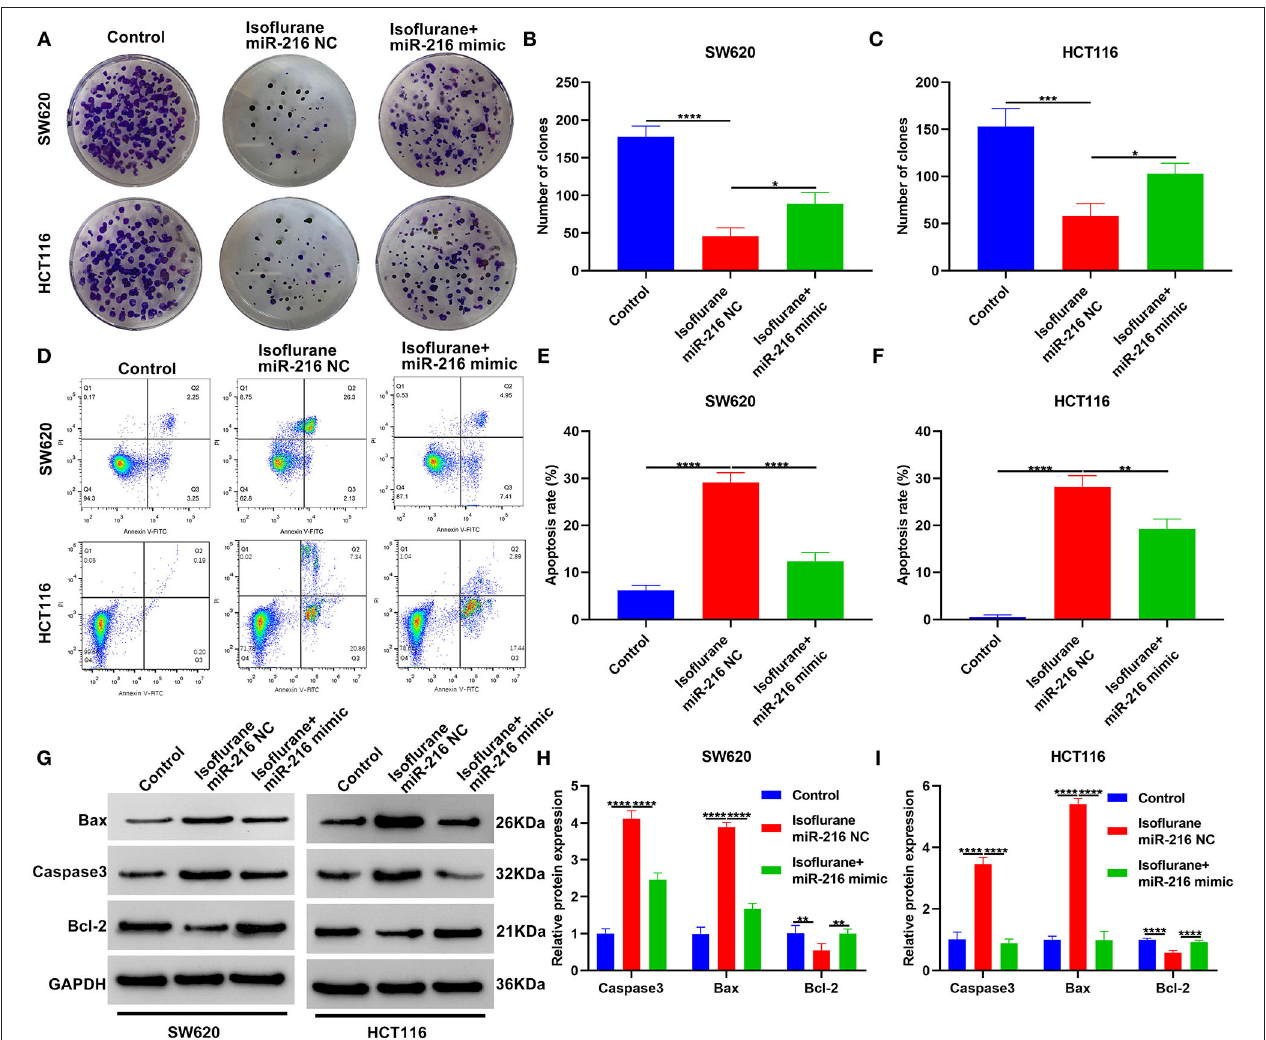
FIGURE 5 | Isoflurane restrains proliferation and facilitates apoptosis in CRC cells partly through miR-216. (A–C) The number of clones of SW620 and HCT116 cells treated with isoflurane and/or miR-216 mimic. (D–F) Apoptotic rate of SW620 and HCT116 cells under treatment with isoflurane and/or miR-216 mimic. (G–I) Expression of Caspase3, Bax and Caspase3 and Bax proteins in SW620 and HCT116 cells following treatment with isoflurane and/or miR-216 mimic. * p < 0.05; ** p < 0.01; *** p < 0.001; **** p < 0.0001.